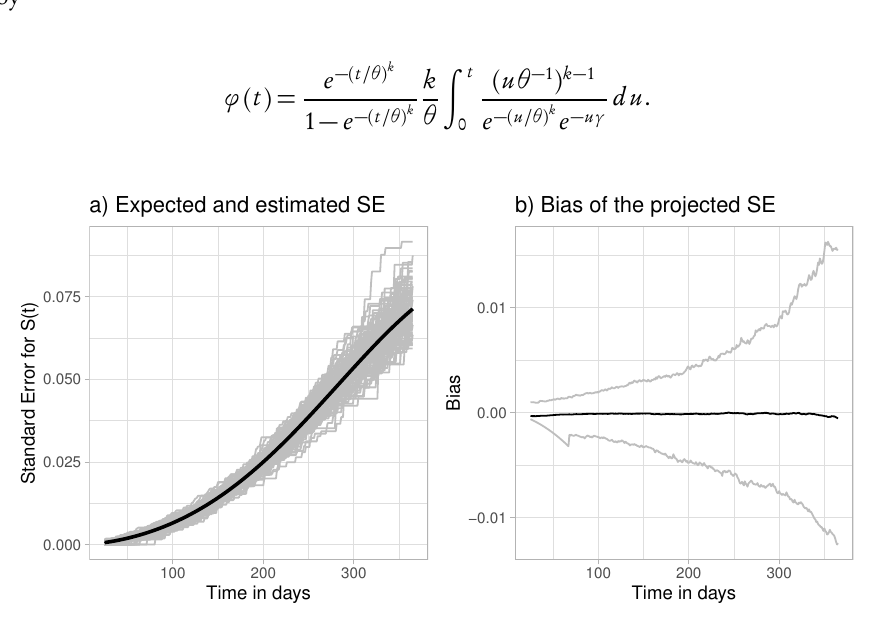
Figure 2 – Results of a simulation study assuming Weibull survival and exponential censoring times depicting (a) the expected (thick black) and estimated (thin grey lines) SE of the survival curve and (b) the bias of the projected SE with 95 % Monte Carlo confidence